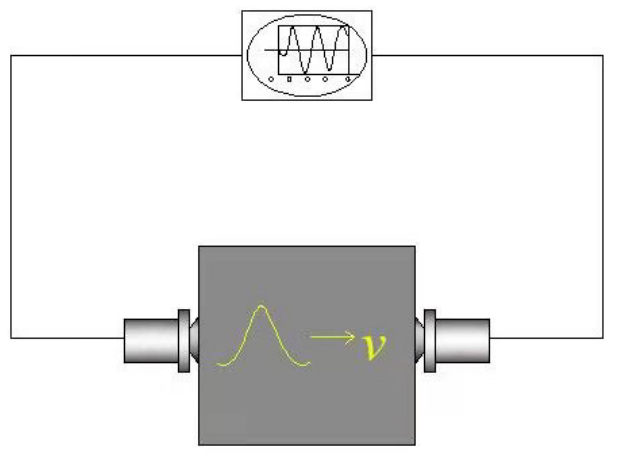
Figure 4. Illustration of an ultrasonic testing method of dynamic elastic modulus.